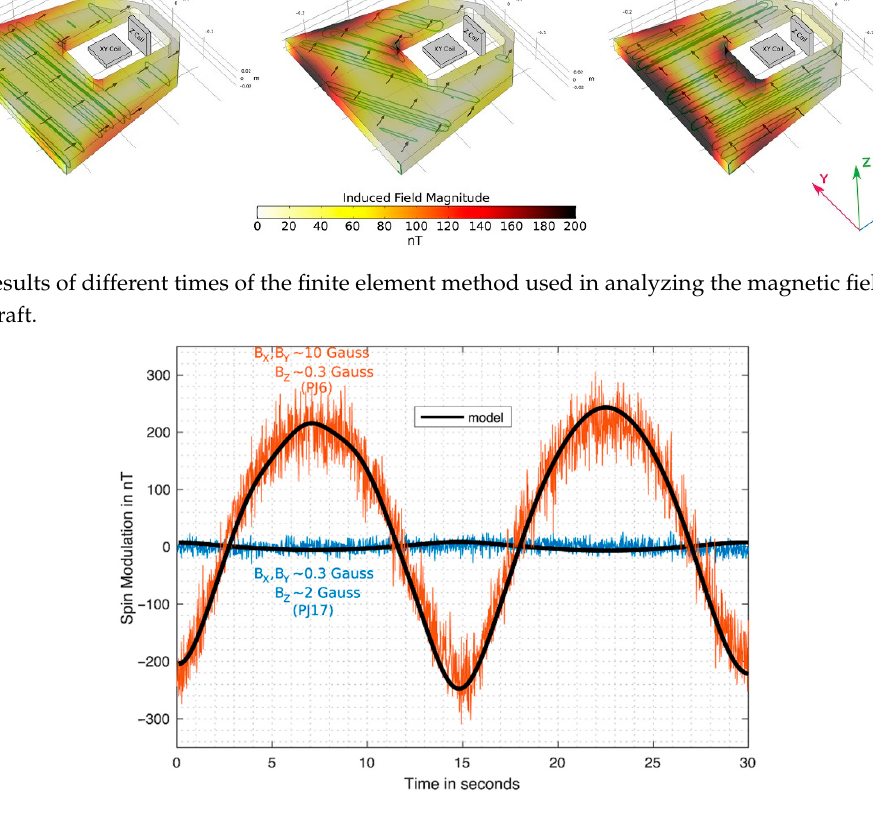
Figure 12. Two different cases of the modulation results. The blue one is for the case with a stronger magnetic field in z direction while the yellow one is for the case with a stronger magnetic field in x-y direction.